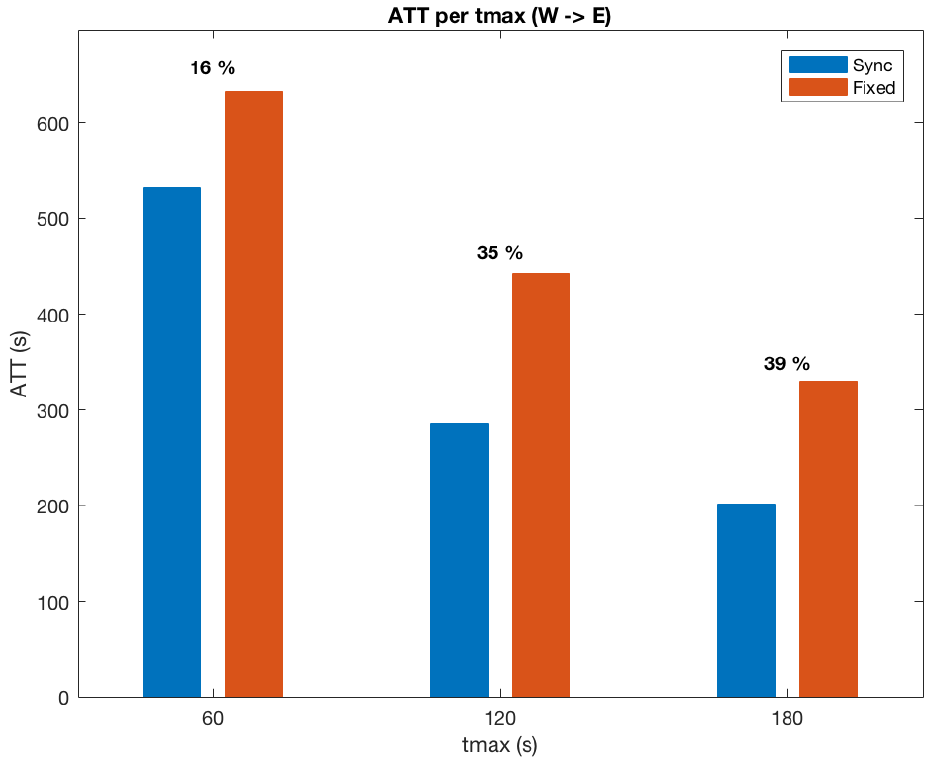
Figure 14. Impact of t max value on the achieved Average Travel Time